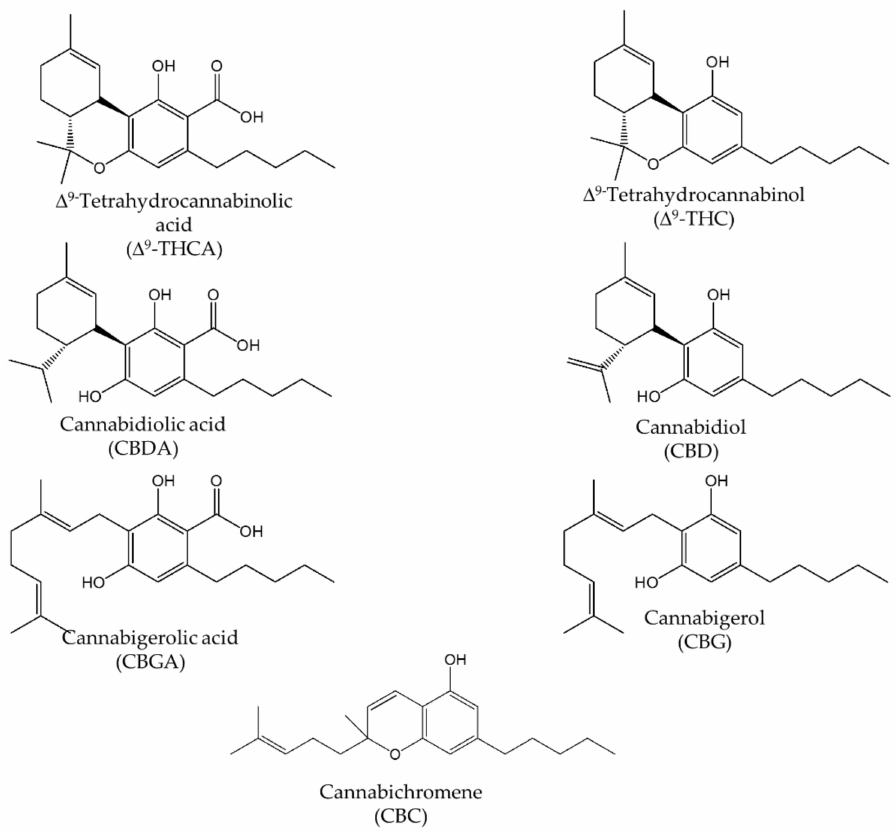
Figure 1. Chemical structures of main cannabinoids present in Cannabis sativa